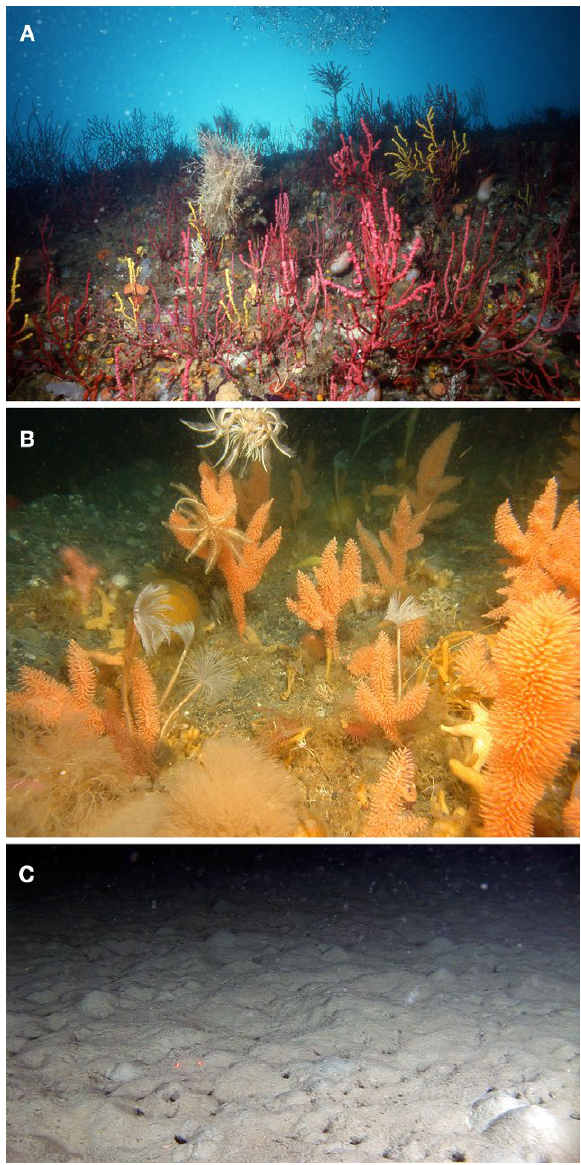
Fig. 3. – Benthic communities inhabiting (A) shallow coastal areas (Mediterranean), (B) continental shelves (Antarctic) and (C) the deep-ocean Mediterranean (Mediterranean). The type and complex- ity of the benthos found depends on the quantity and quality of en- ergy reaching its habitat. Types A and B are typical of areas where distance from surface to bottom is shallower with fewer bounda- ries to go through. Type C represents a typical oceanic seafloor, where the materials coming from the water column above have long been reworked and contain less energy. (Pictures by A, J. Gili, ICM-CSIC; B, Julian Gutt AWI-Bremerhaven; C, Jürgen Schauer